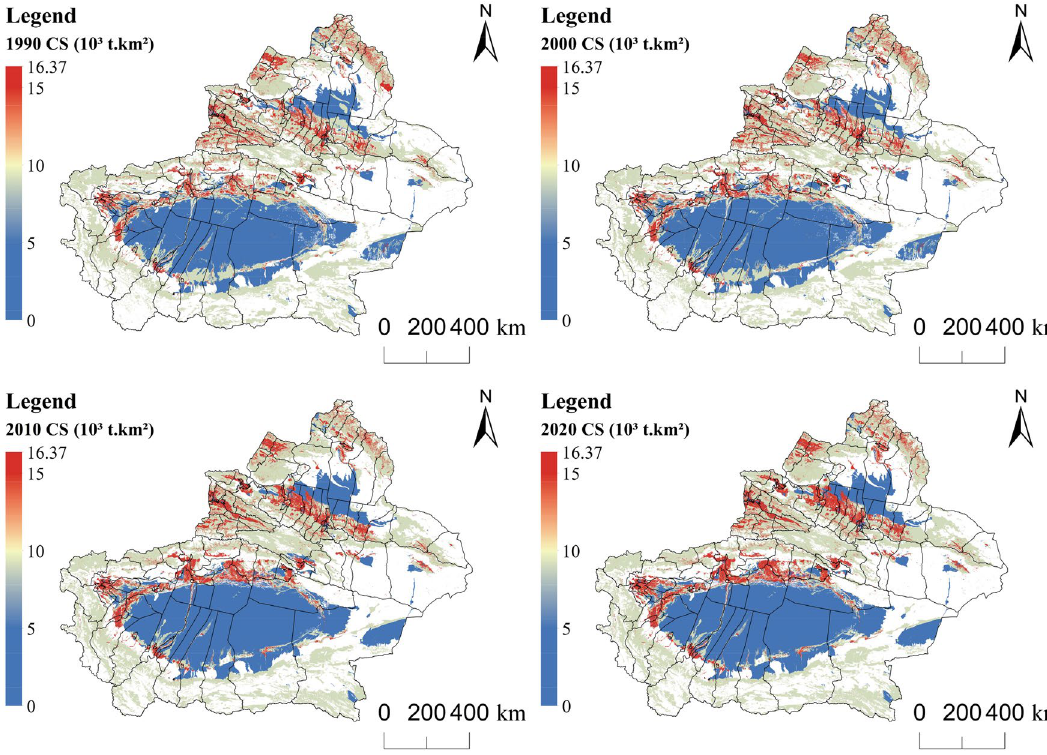
Figure 6. Changes in carbon sequestration in Xinjiang ecosystems. Map generated with ArcGIS 10.8 (ESRI). URL: https:// suppo rt. esri. com/ en/ Produ cts/ Deskt op/ arcgis- deskt op/ arcmap.